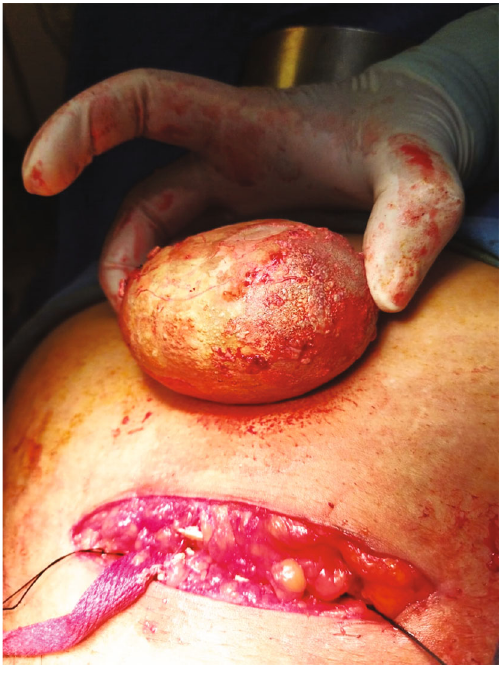
Figure 2: Stone after removal from bladder.